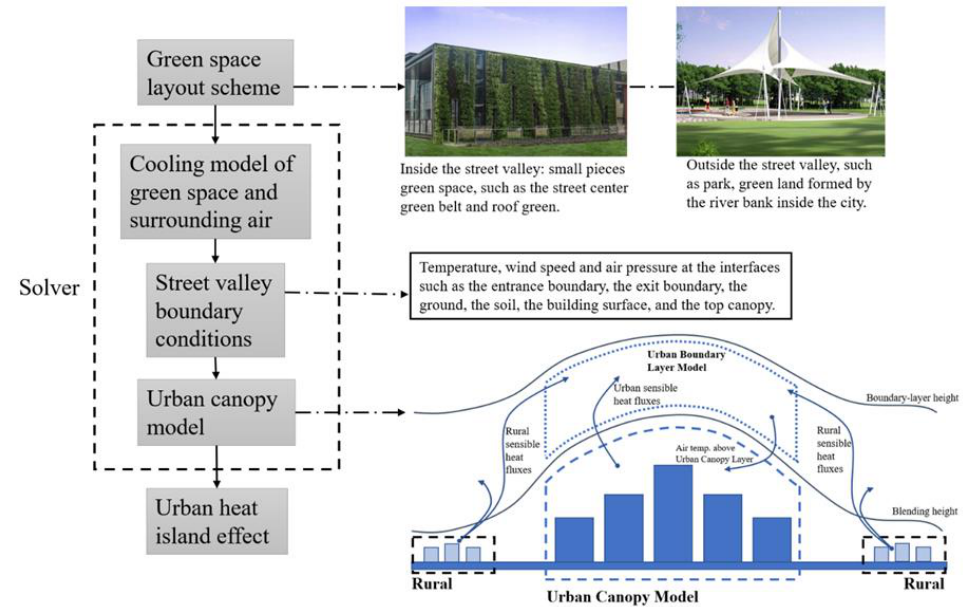
Figure 1. Model of optimal layout of urban green space. The schematic diagram of urban boundary layer model was from Ref. [56].